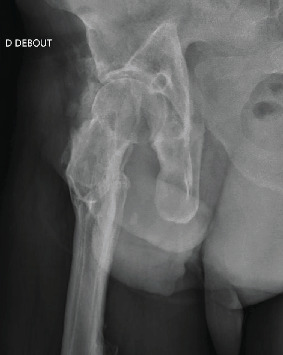
Lateral view of the X-ray in Figure 5.